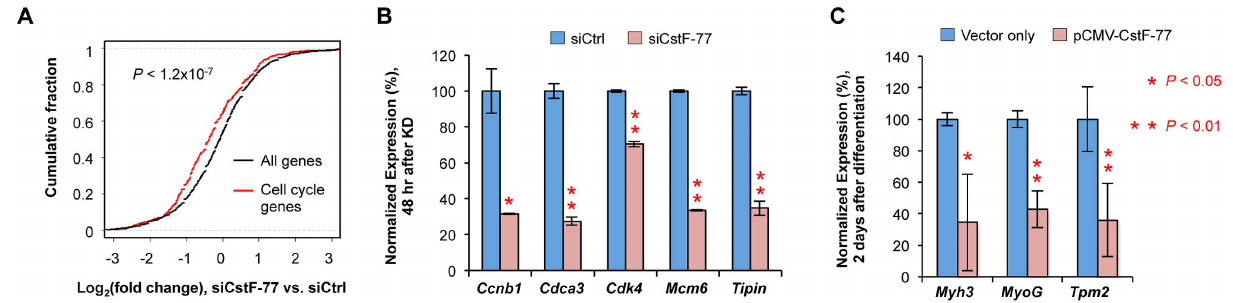
Figure 8. Cell cycle genes are affected by CstF-77 knockdown. ( A ) Cumulative fraction for gene expression changes (siCstF-77 vs. siCtrl) of all genes analyzed (11,396 in total) or cell cycle genes (540 in total). ( B ) Validation of mRNA expression changes by RT-qPCR for several cell cycle-related genes after CstF-77 knockdown. P-values (T-test) are indicated. ( C ) mRNA expression of C2C12 differentiation marker genes in cells over-expressing CstF-77 after 2 days of differentiation. Values were normalized to that of vector only. P-values are based on the T-test.